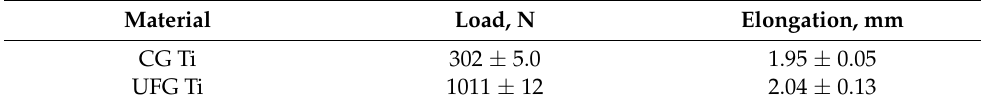
Figure 7. Tensile curves for the plates from CG ( a ) and UFG ( b ) Ti. Table 4. Plate fracture parameters.